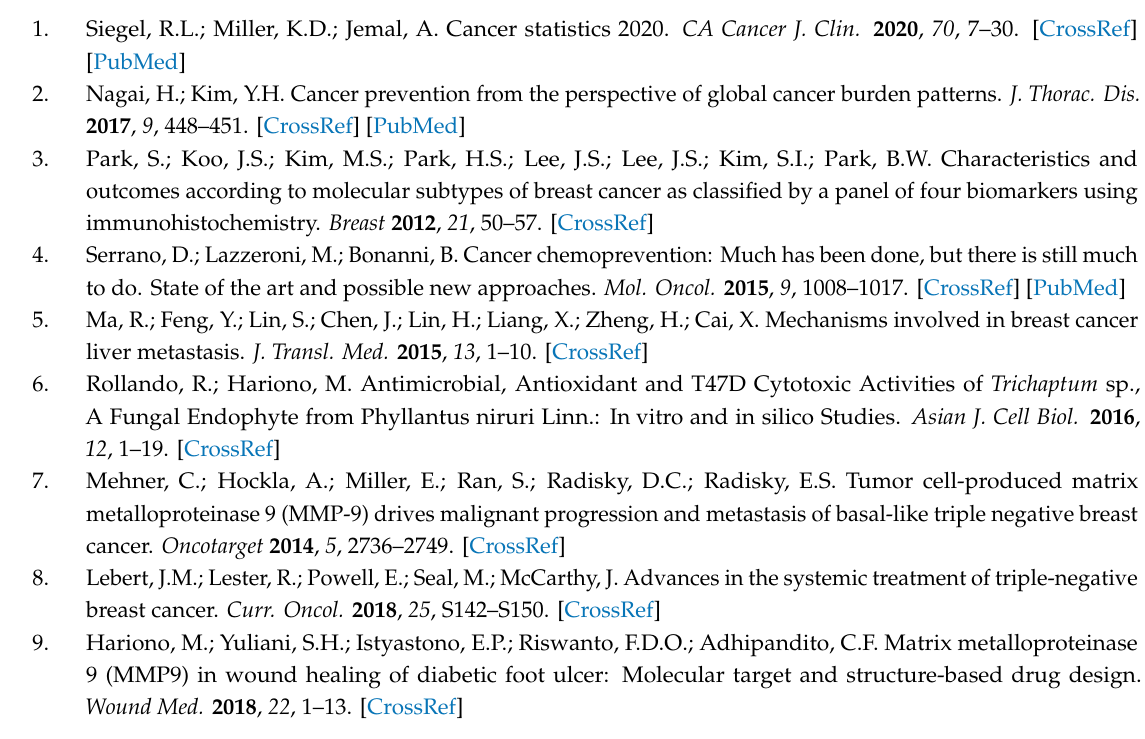
Supplementary Materials: The following are available online, Figure S1: The mass spectra of three peaks identified from GC chromatogram of Ixora fraction 1., Table S1: The binding a ffi nity of published PEX9 inhibitors predicted by molecular docking compared to their experimental dissociation constant upon PEX9 inhibition, Table S2: The yield of Ageratum conyzoides and Ixora coccinea fractions of ethylacetate and n-hexane,